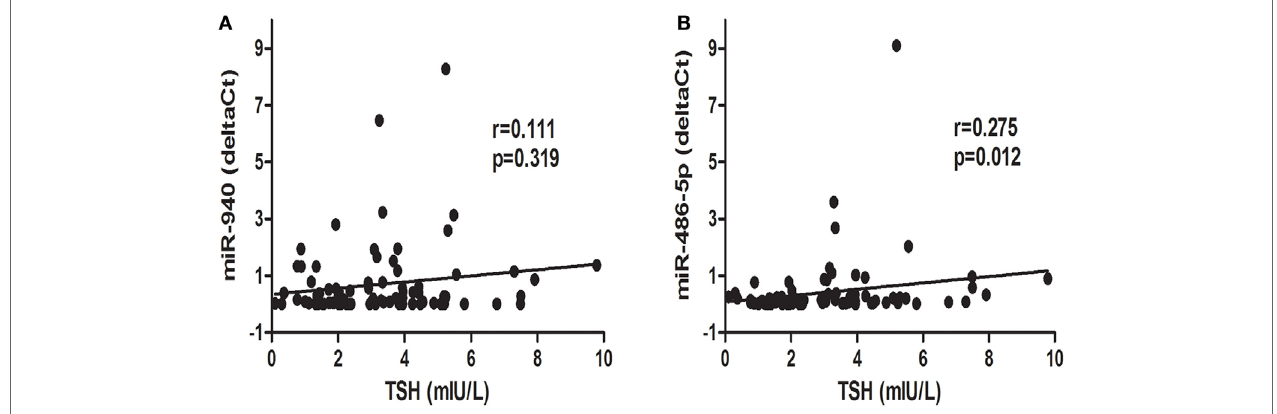
FigUre 4 | Correlation analysis of differentially expressed microRNAs, miR-940 (a) and miR486-5p (B) , and thyroid-stimulating hormone (TSH) levels; p < 0.05 was considered